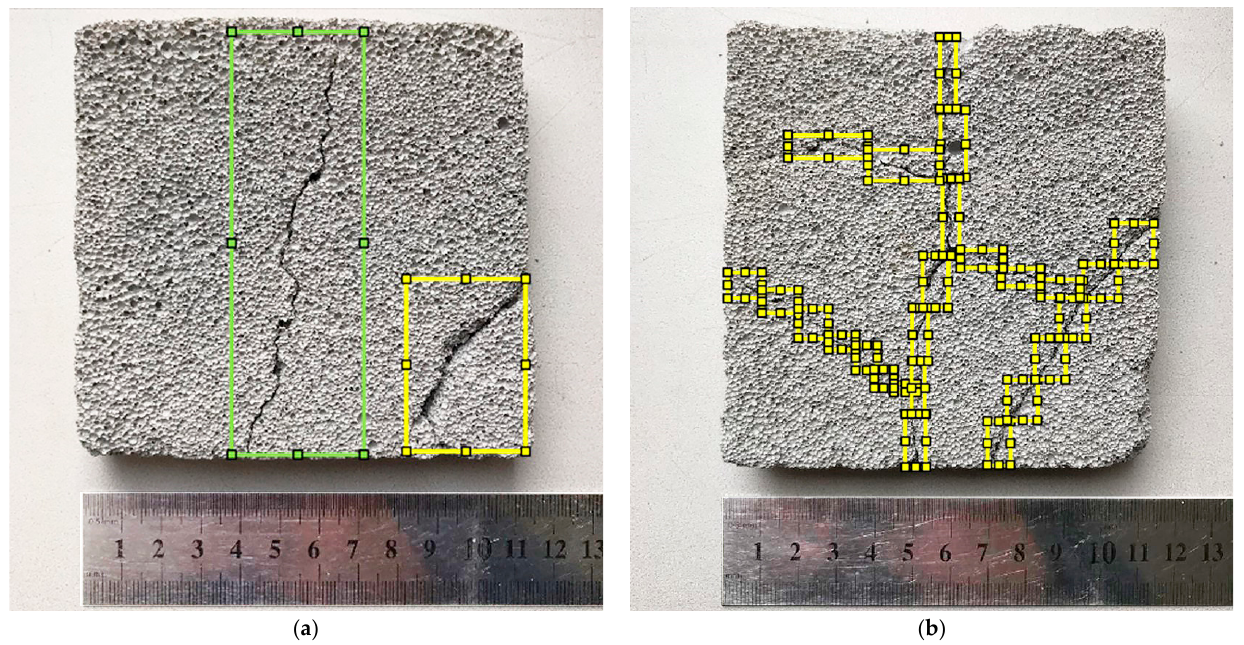
Figure 2. Markup methods: ( a ) allocating a crack with a full bounding box, and ( b ) dividing the image into patches.